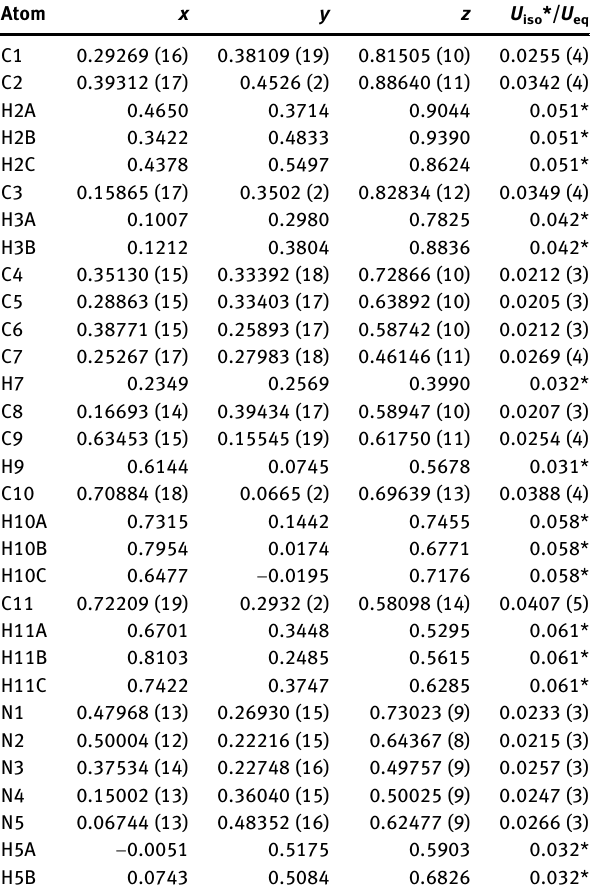
isotropic displacement parameters (Å 